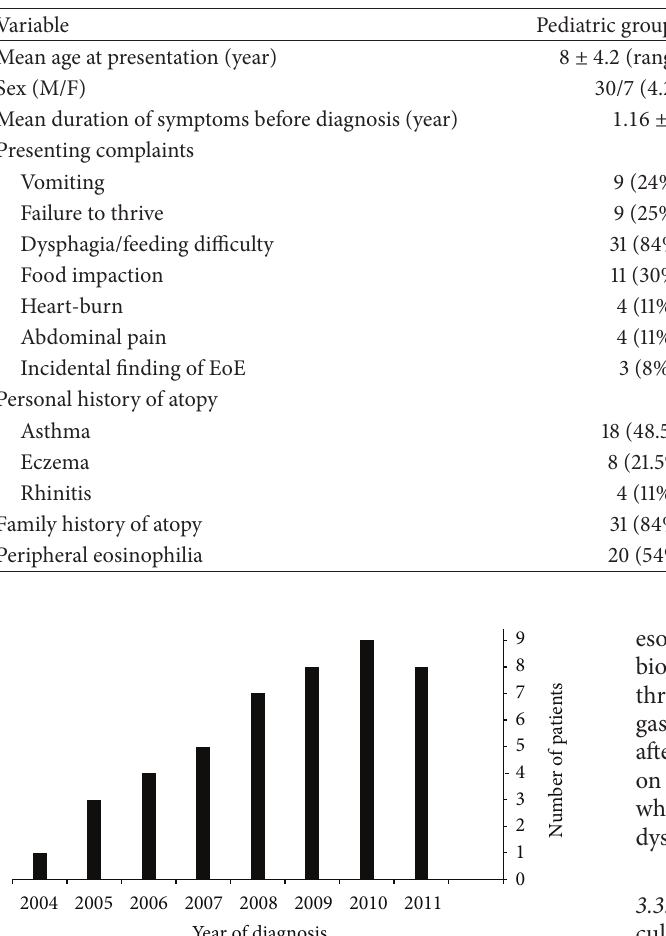
Table 1: Clinical characteristics of patients with eosinophilic esophagitis.